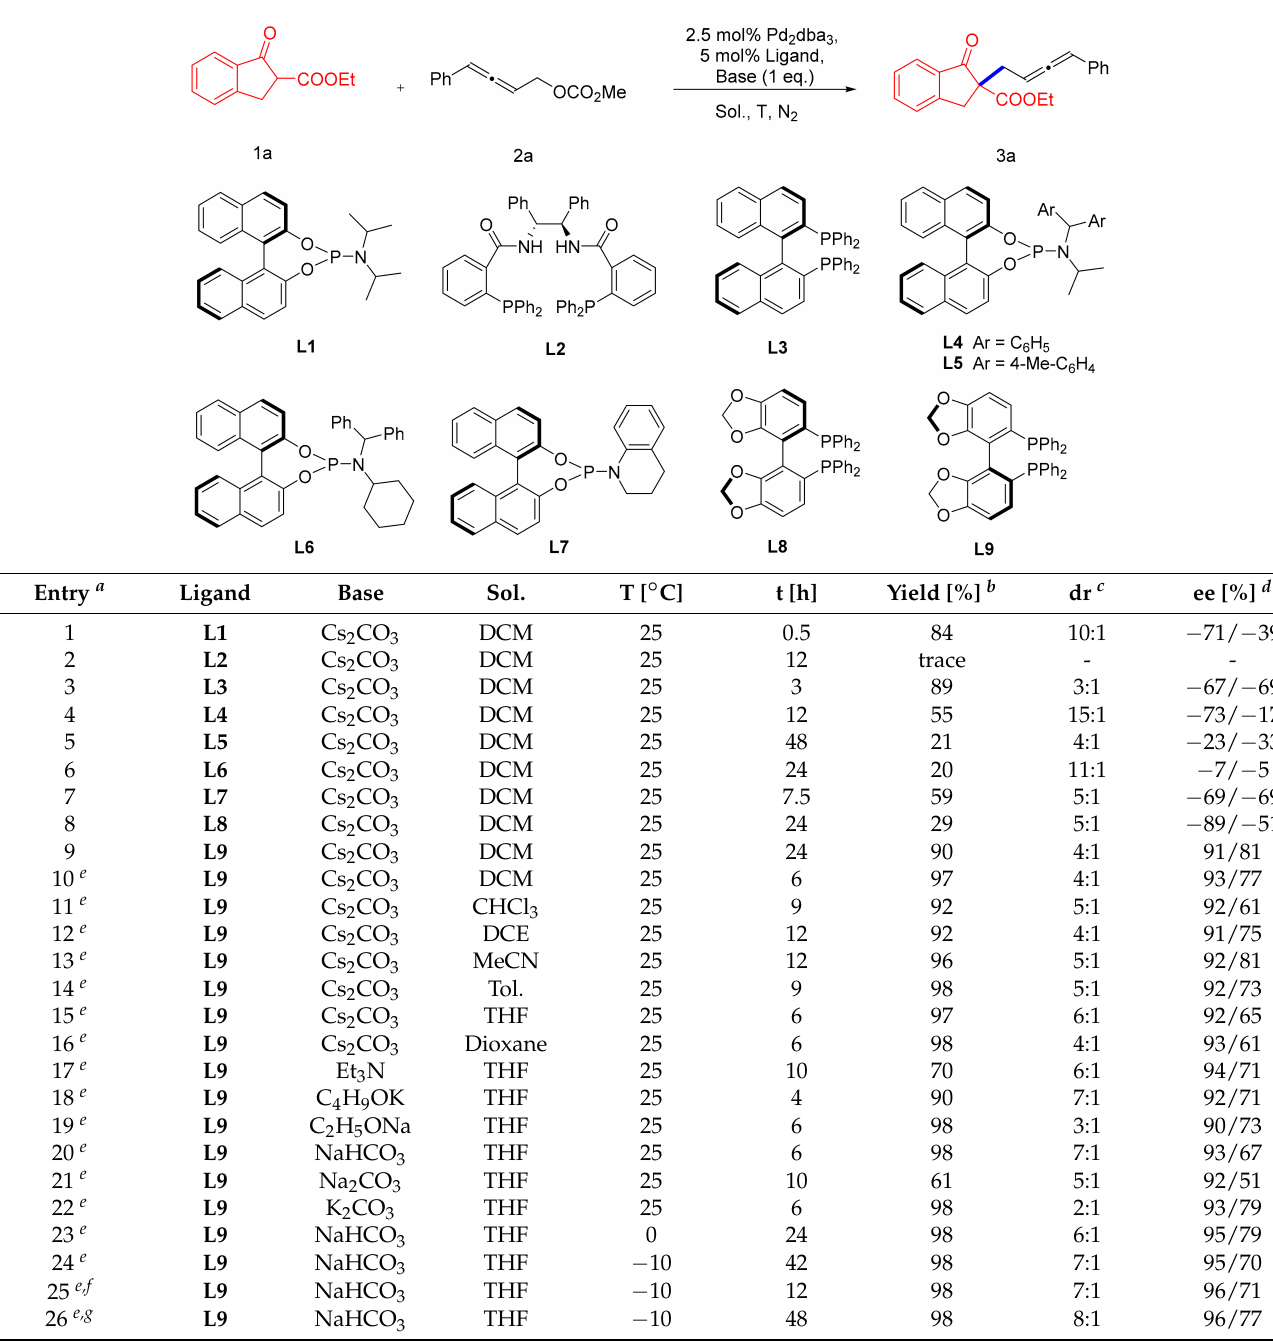
Table 1. Optimization of reaction